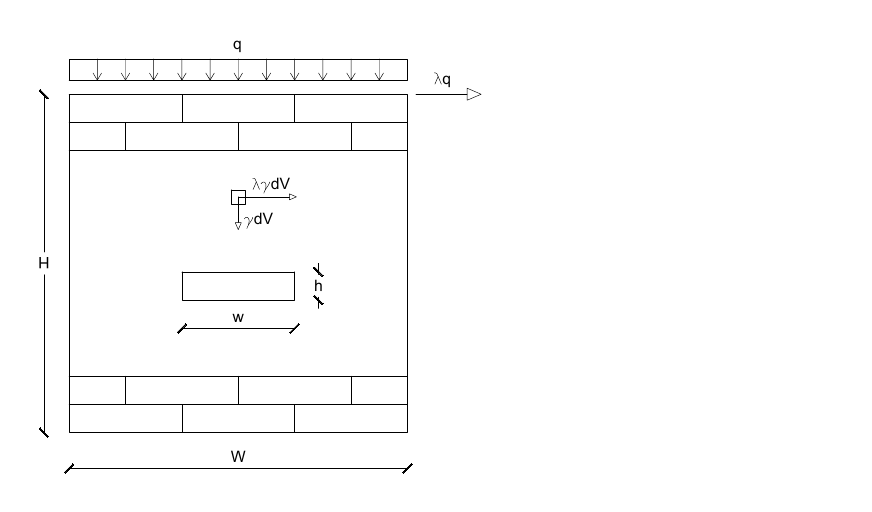
Figure 4. Geometrical parameters of the wall and of the blocks and applied